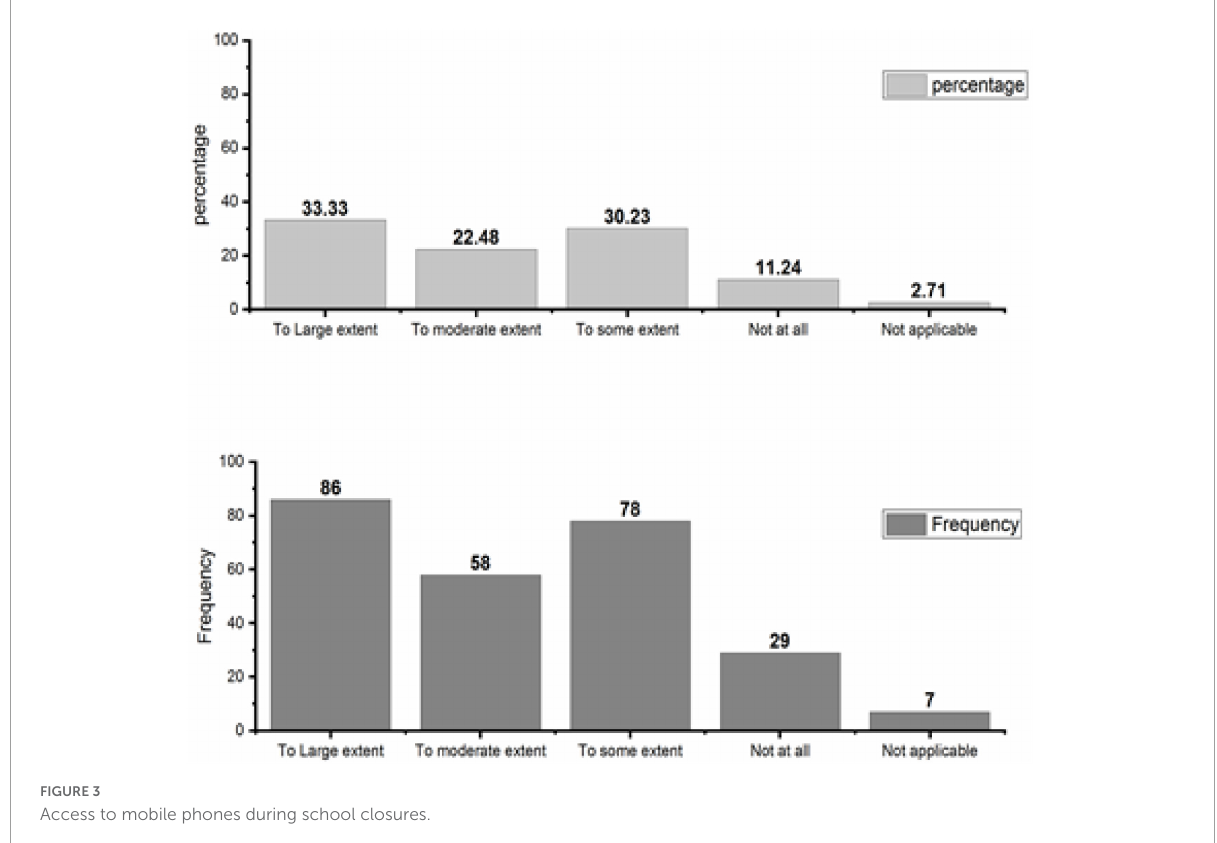
FIGURE3 Access to mobile phones during school closures.